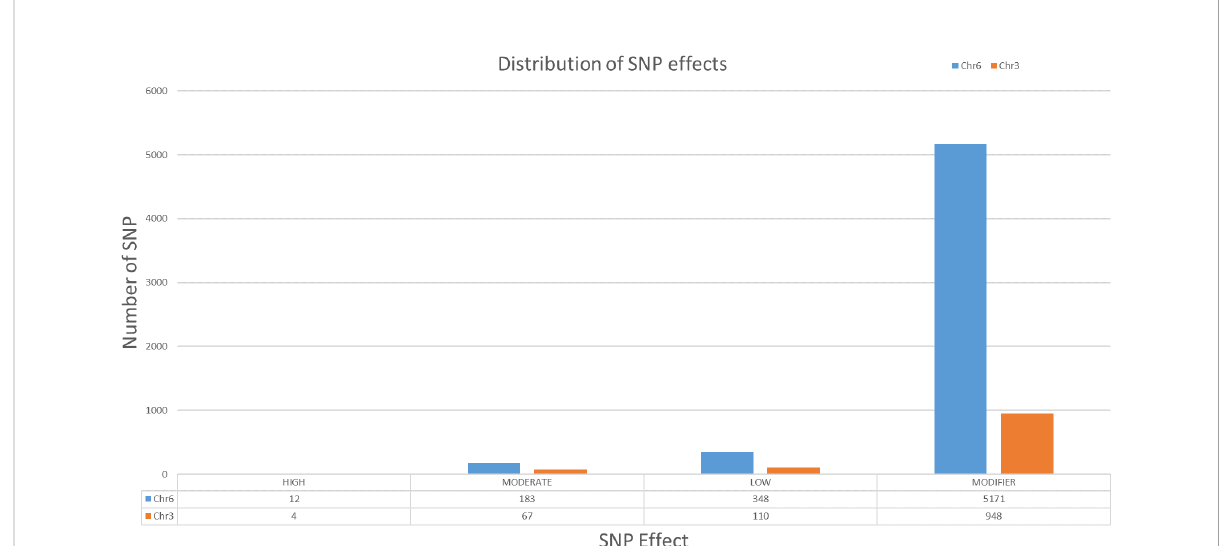
FIGURE 6 Distribution of SNP according to the effect in chromosome 3 and 6 of cucumber.